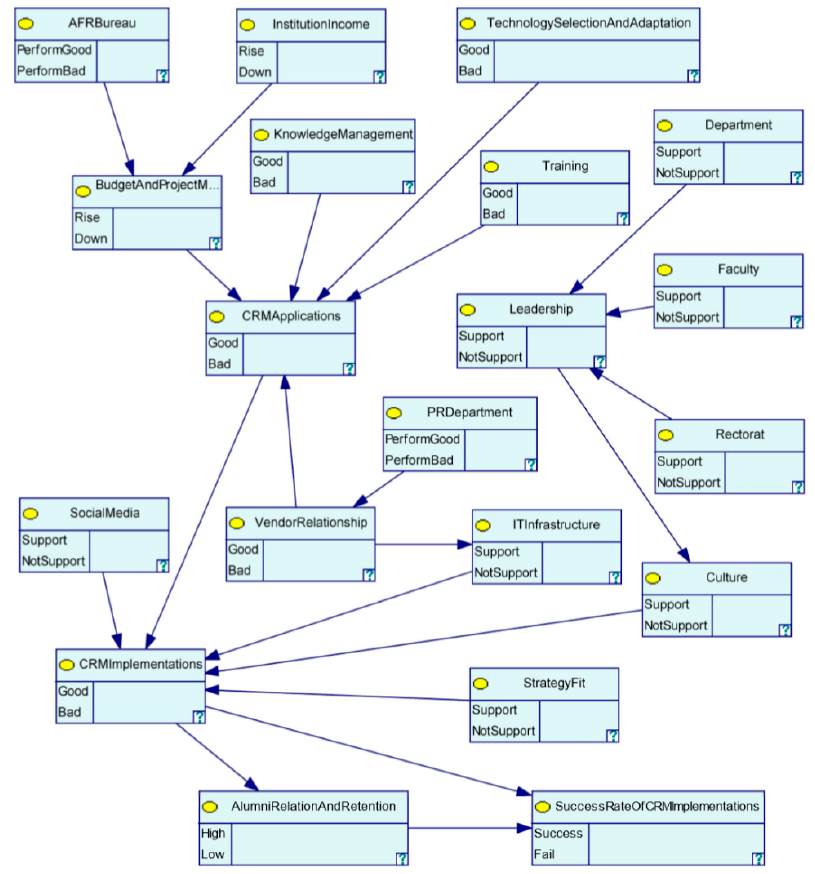
Figure 8. Social CRM: the relationships between the factors.